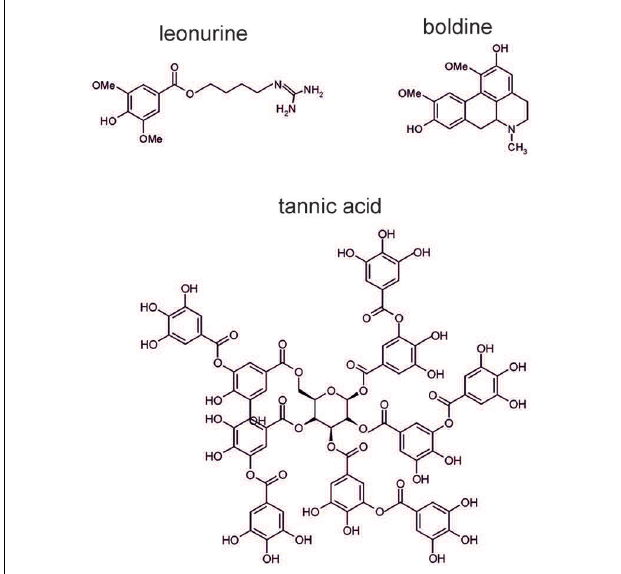
FIGURE 6 | Molecular structures of the alkaloids leonurine, boldine, and tannic